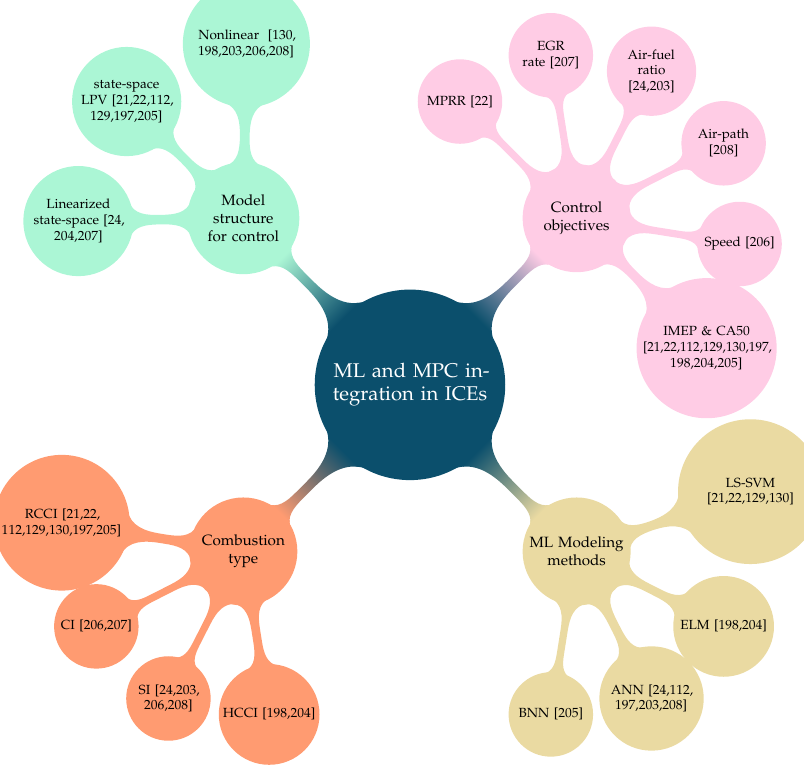
Figure 16. ML and MPC integration